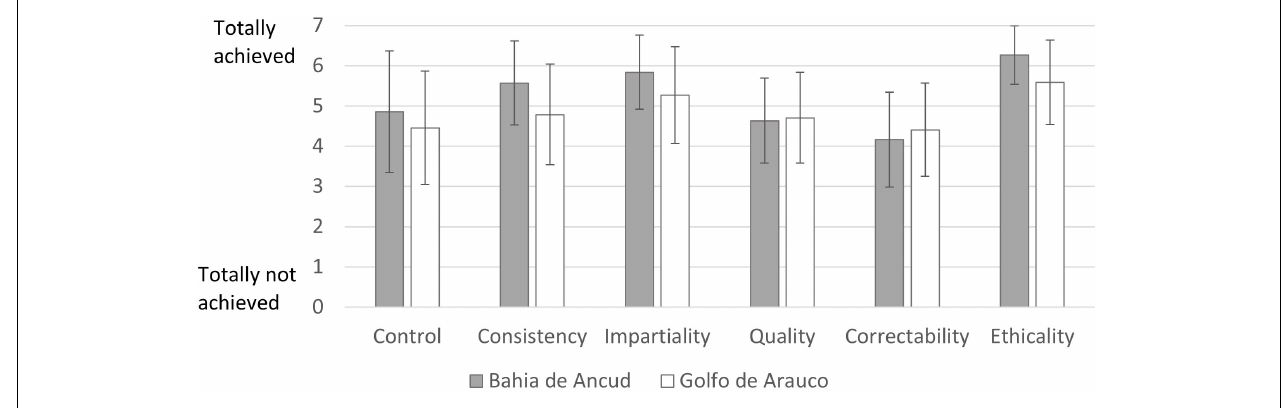
FIGURE 3 | Average of the rules for the two case studies. Individual results are presented in Supplementary Material